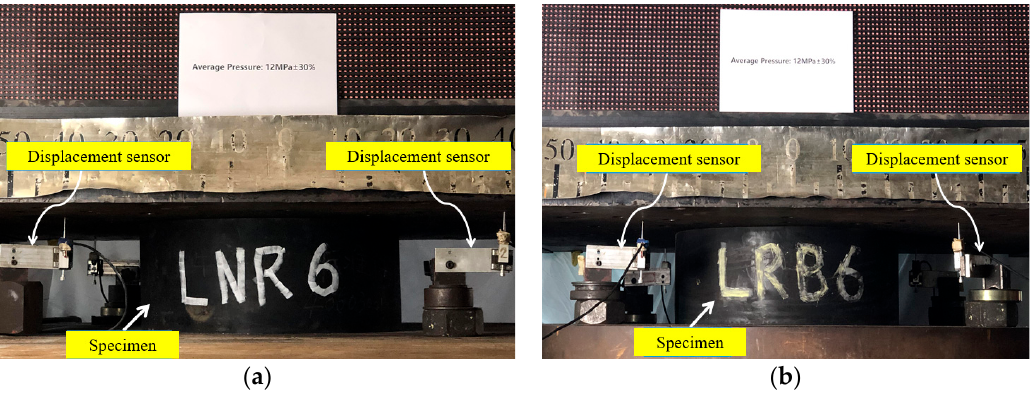
Figure 5. Two specimens (under compression loads) and sensors on the tester: ( a ) NRB ‐ 600; ( b ) LRB ‐ 600.